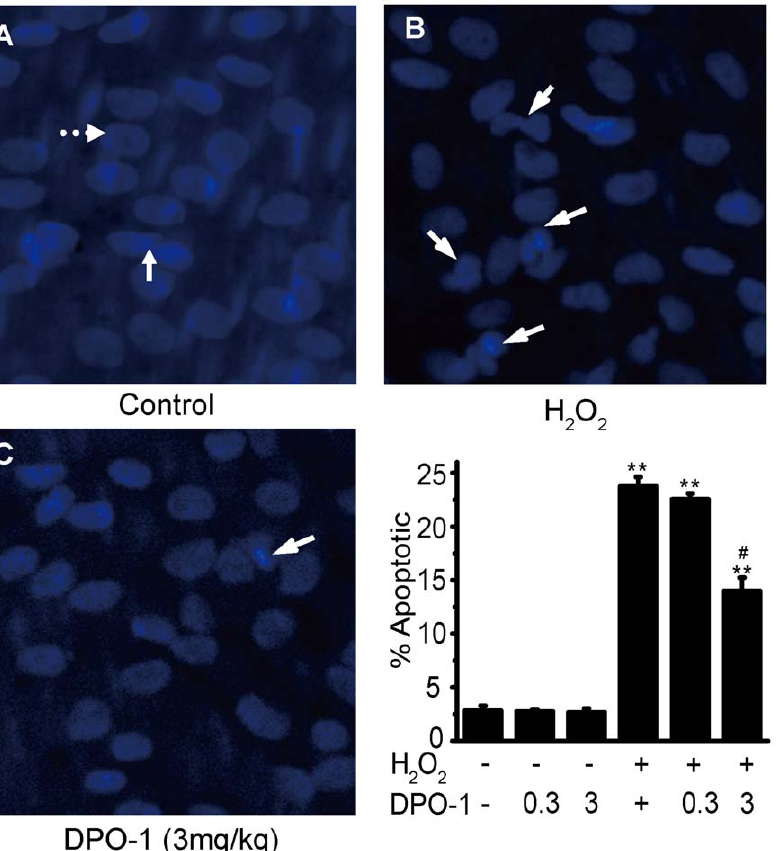
Figure 1. Kv1.5 inhibitor, DPO-1 attenuated H 2 O 2 -induced invivo EC apoptosis in rat carotid artery. DPO-1(0.3, 3 mg/kg) was i.p. dose administrated at 6 hours after H 2 O 2 injury. Representative morphological changes of apoptotic ECs were determined by en face Hoechst 33342 staining in Control (A), H 2 O 2 injury (B) and DPO-1 treatment (C) groups. The contralateral side of carotid artery at 6 h after injury served as control, nuclear morphology of normal ECs (round, shown by full line arrow in (A)) and VSMCs (spindle-shaped, shown by dotted line arrow in (A)) can be observed. In (B) & (C), the white arrows show typical apoptotic morphological changes in apoptotic ECs, including chromatin condensation and nuclear fragmentation. The values were presented as 6 SEM of 6 independent experiments. * P , 0.01 vs. control, # P , 0.01 vs. H 2 O 2